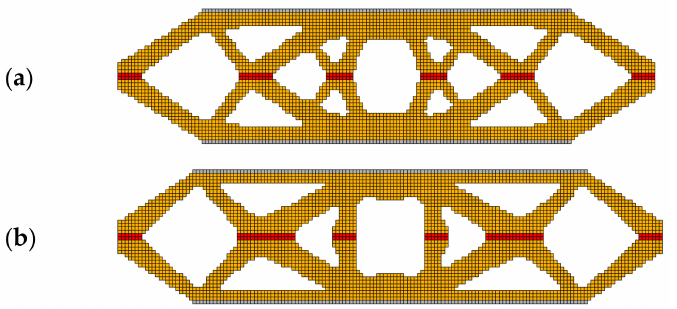
Figure 15. The final topologies for the FGM structure: E 1 —red color, E 2 —gray color, FGM— yellow color; RAMP interpolation scheme: ( a ) E 1 = 10 11 Pa E 2 = 2 × 10 11 Pa, minimal compliance: 9.330 × 10 − 4 Nm; ( b ) E 1 = 10 11 Pa E 2 = 10 12 Pa, minimal compliance: 3.706 × 10 − 4 Nm.